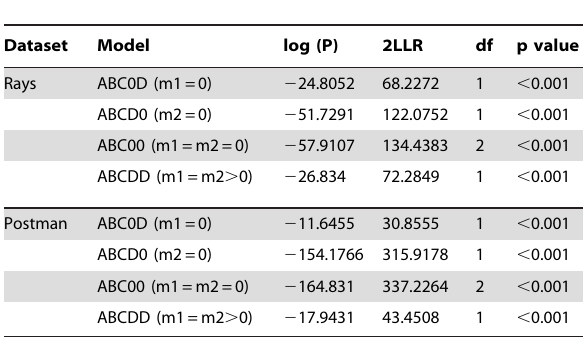
Table 3. Summary of likelihood ratio test statistics for the IMa